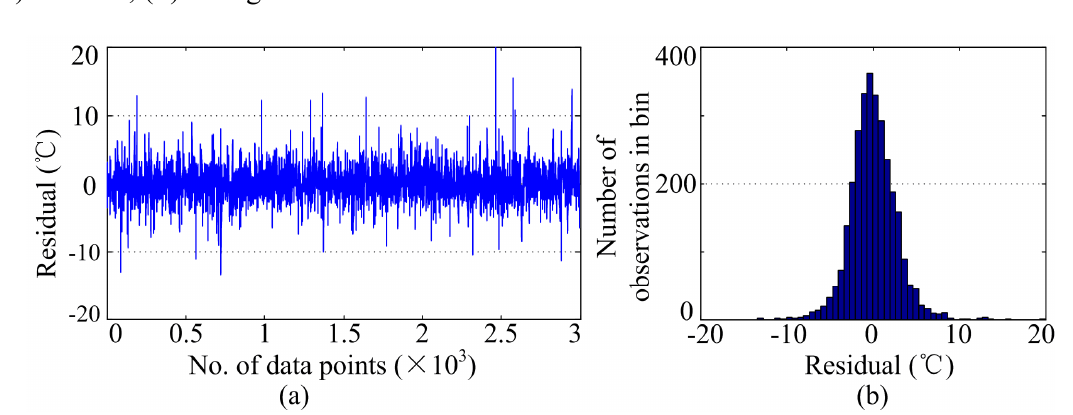
Figure 9. Residual of the model for the temperature of generator bearing B in WT 17: ( a ) residual; ( b ) histogram of